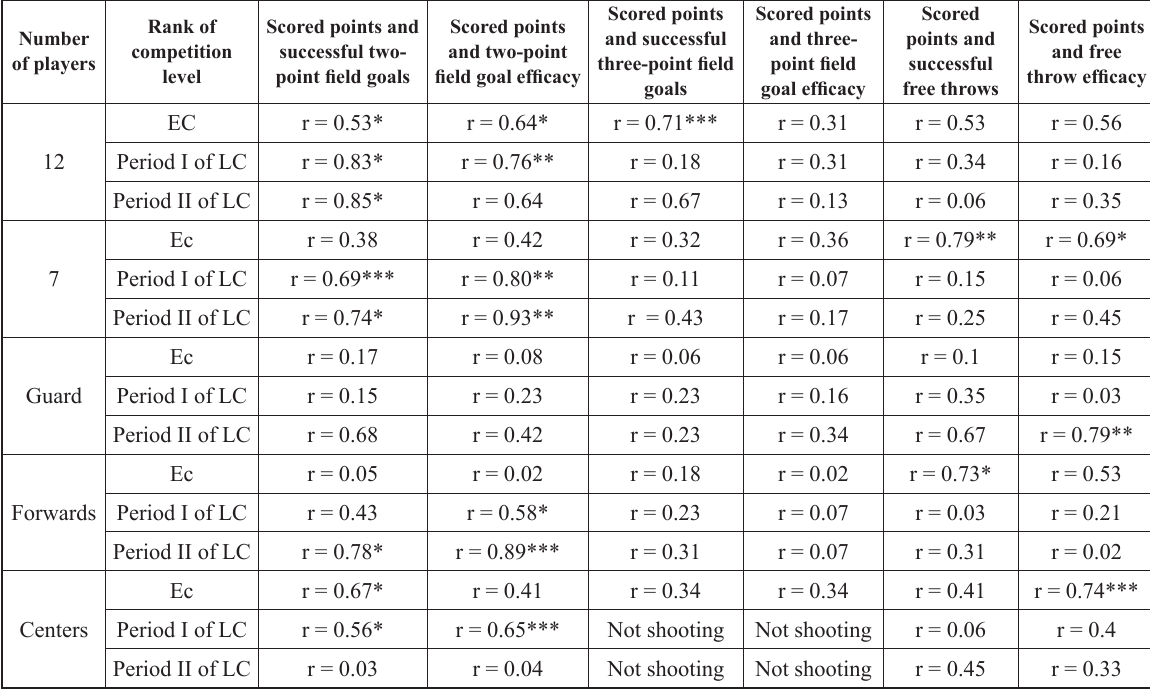
Table 3. LBC players’ correlations of different evaluated points and playing positions